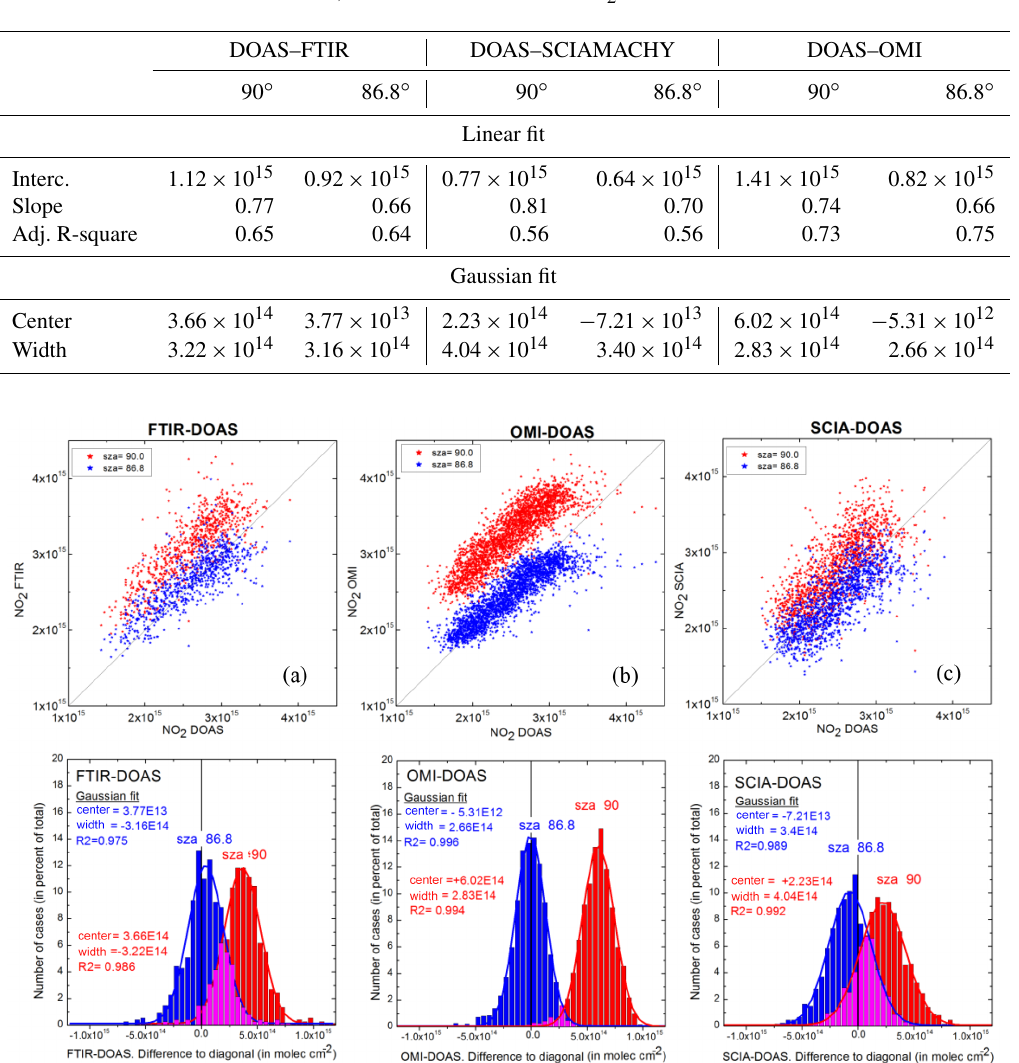
Figure 4. Upper panel: scatter plot of the NO 2 measured by DOAS instrument ( x axis) and (a) FTIR, (b) OMI and (c) SCIAMACHY in the y axis. The effective SZA = 90 ◦ is presented in red stars and effective SZA = 86.8 ◦ in blue stars. Solid diagonal represents the ideally perfect agreement. Lower panel: frequency distribution of the distance of each cross-correlation point to the diagonal considering for the photochemical correction the local SZA at 90 ◦ (red) and the effective SZA at 86.8 ◦ (blue). See text for